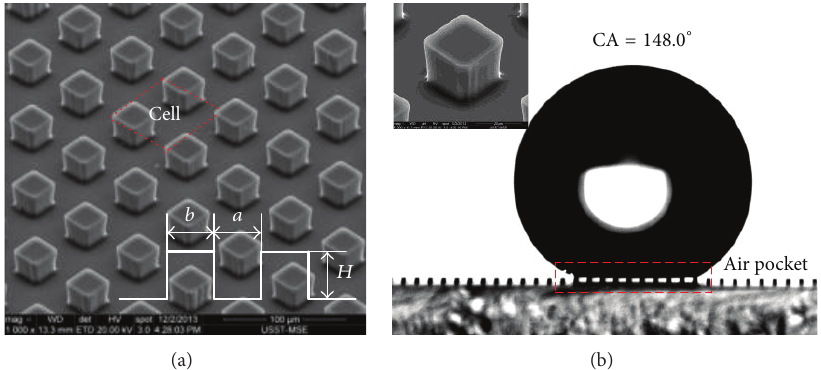
Figure 2: (a) SEM image of pillar structures made of PDMS ( 𝑎 is the pillar spacing, 𝐻 is the height of the pillars, and 𝑏 is the width). (b) Wetting state and contact angle of droplet of 4 𝜇 L on the microstructured